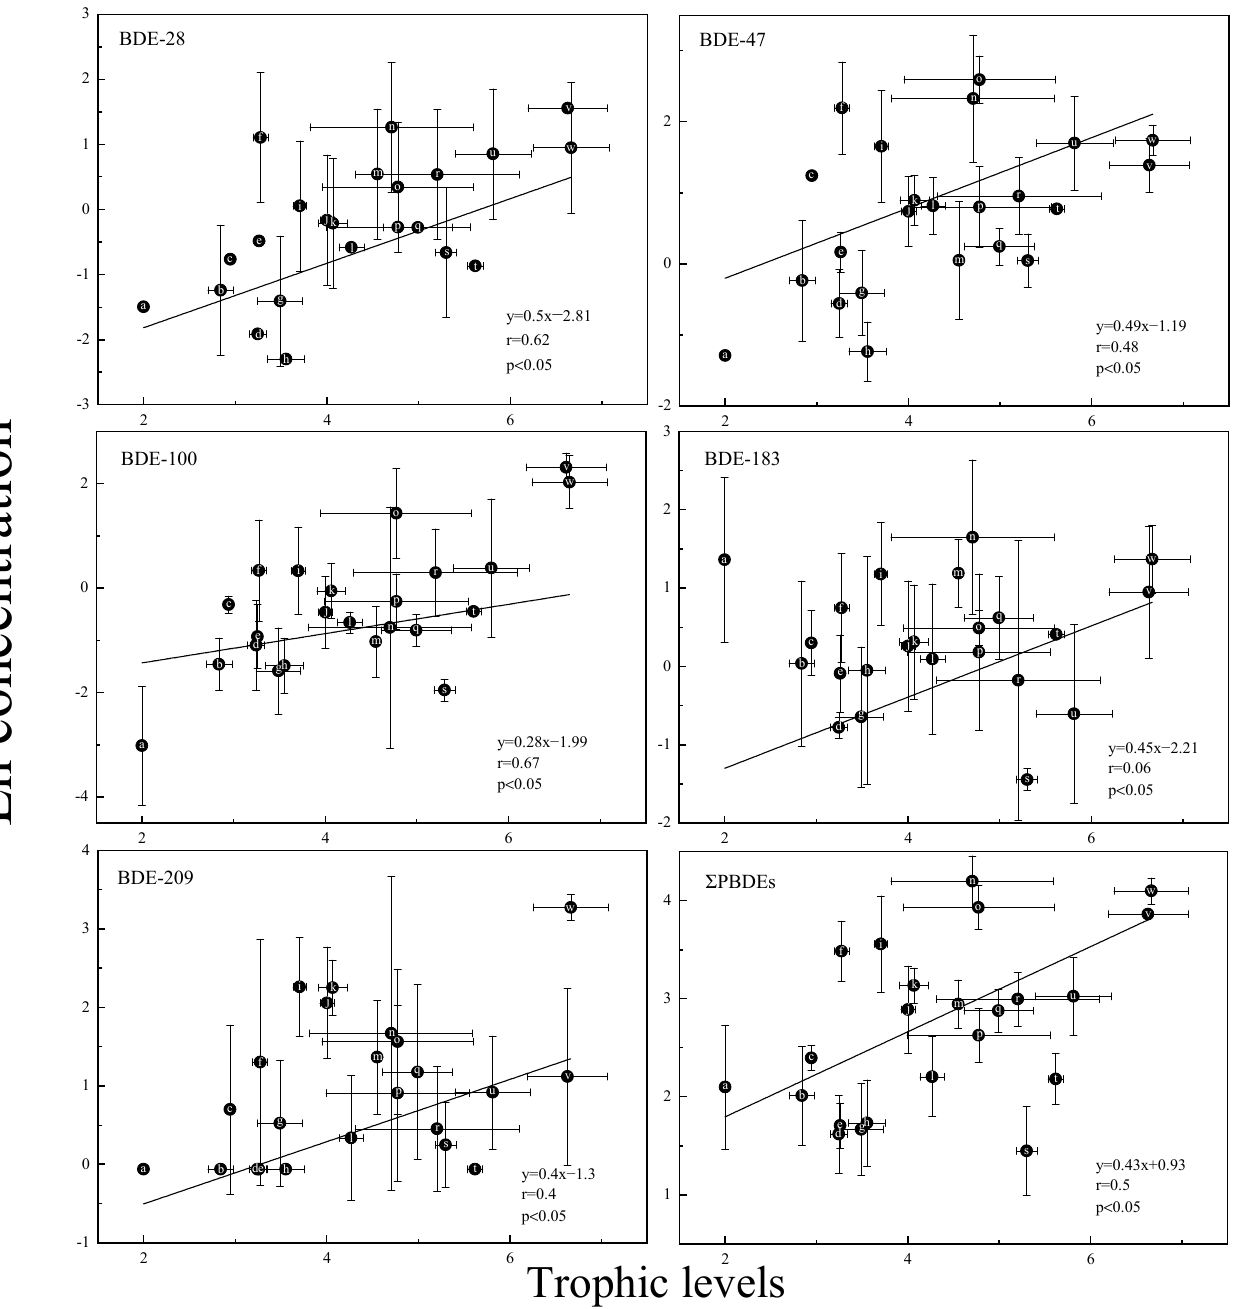
Figure 4. Relationship of the natural logarithm of PBDE congener concentration (ng/g lw) and TLs calculated from δ 15 N values ( p < 0.05). (In the figure: a: Plankton; b: Grass crap; c: Aucha perch; d: Bighead carp; e: Black carp; f: Oriental sheatfish; g: Loach; h: White amur bream; i: Yellow catfish; j: Crucian carp; k: Northern snakehead; l: Silver carp; m: Shrimp; n: Culter alburnus; o: Common carp; p: White semiknife carp; q: Crab; r: Finless eel; s: English perch; t: Japanese eel; u: Coilia nasus; v: Silver sillago; w: River snail.).